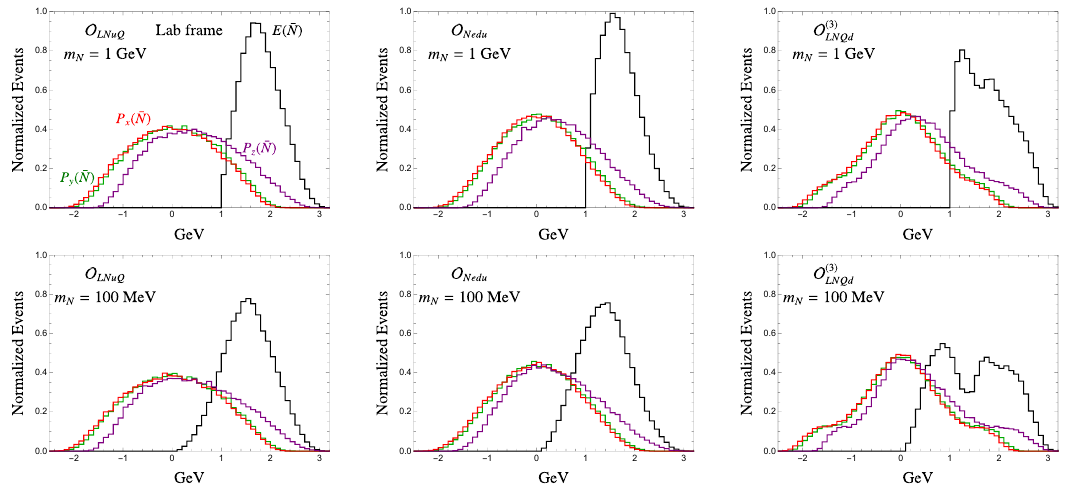
Figure 8 . Four-momentum distributions for ¯ N in the lab frame from three-body B decay for the three production operators with m N = 1 GeV (upper panels) and m N = 100 MeV (lower panels). The four-momentum distributions for m N = 5 MeV are similar to those for m N = 100